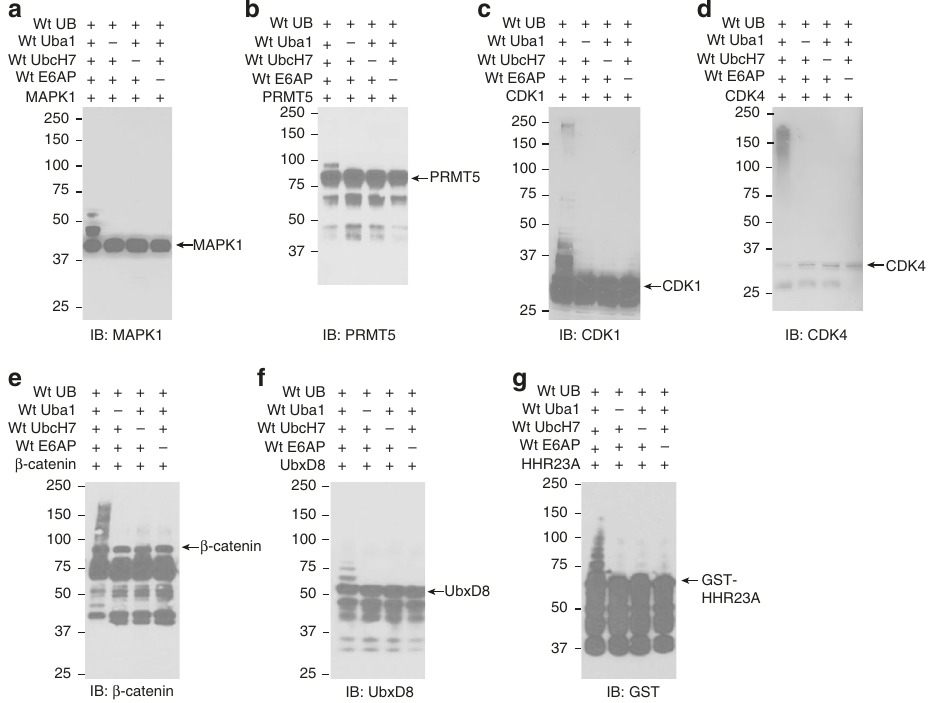
Fig. 5 In vitro assays to test ubiquitination of E6AP substrates identi fi ed by OUT. wt UB was transferred through wt Uba1-UbcH7-E6AP cascade to the potential substrate proteins expressed from E . coli cells. E6AP ubiquitination of MAPK1 a , PRMT5 b , CDK1 c , CDK4 d , β -catenin e , and UbxD8 f , were con fi rmed. E6AP-catalyzed ubiquitination of HHR23A, a previously reported E6AP substrate, was also assayed g . All blots are representative of at least three independent